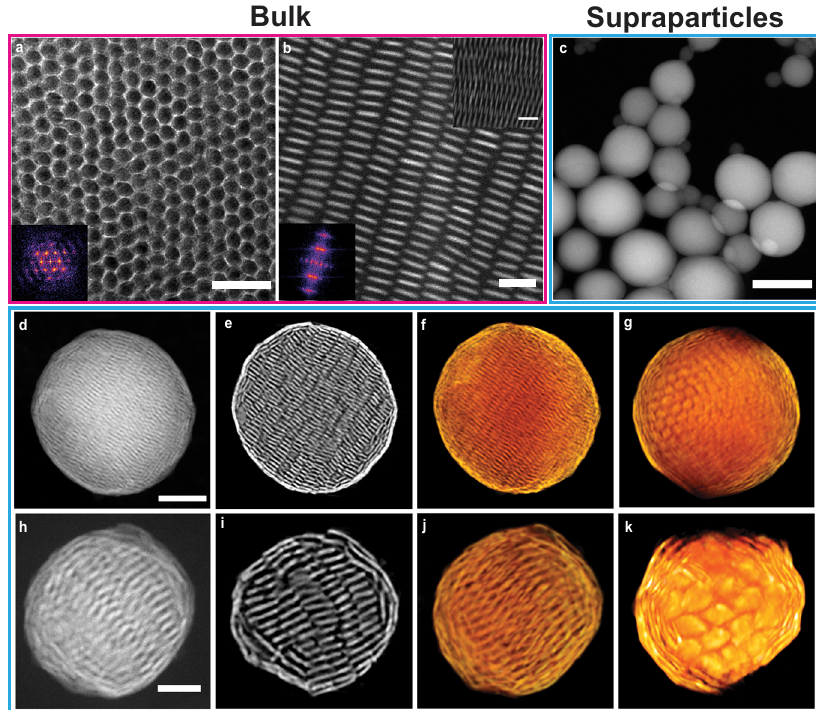
Fig. 6 | SPscomposed ofleaf-shaped GdF 3 NPLs. 2DHAADF-STEMimages ofself- assembled superlattices composed of leaf-shaped GdF 3 NPLs where the NPLs a lay fl at face-to-face on the substrate, showing a hexagonal symmetry and b align on the substrate with their edges, showing a two-fold symmetry. c Overview of self-assembled SPs of leaf-shaped GdF 3 NPLs. d , h 2D HAADF-STEM images, e , i Tomographic reconstructed orthoslices and f , j 3D representations of two self- assembled SPs with a diameter of d 180nm and h 122nm, respectively, showing